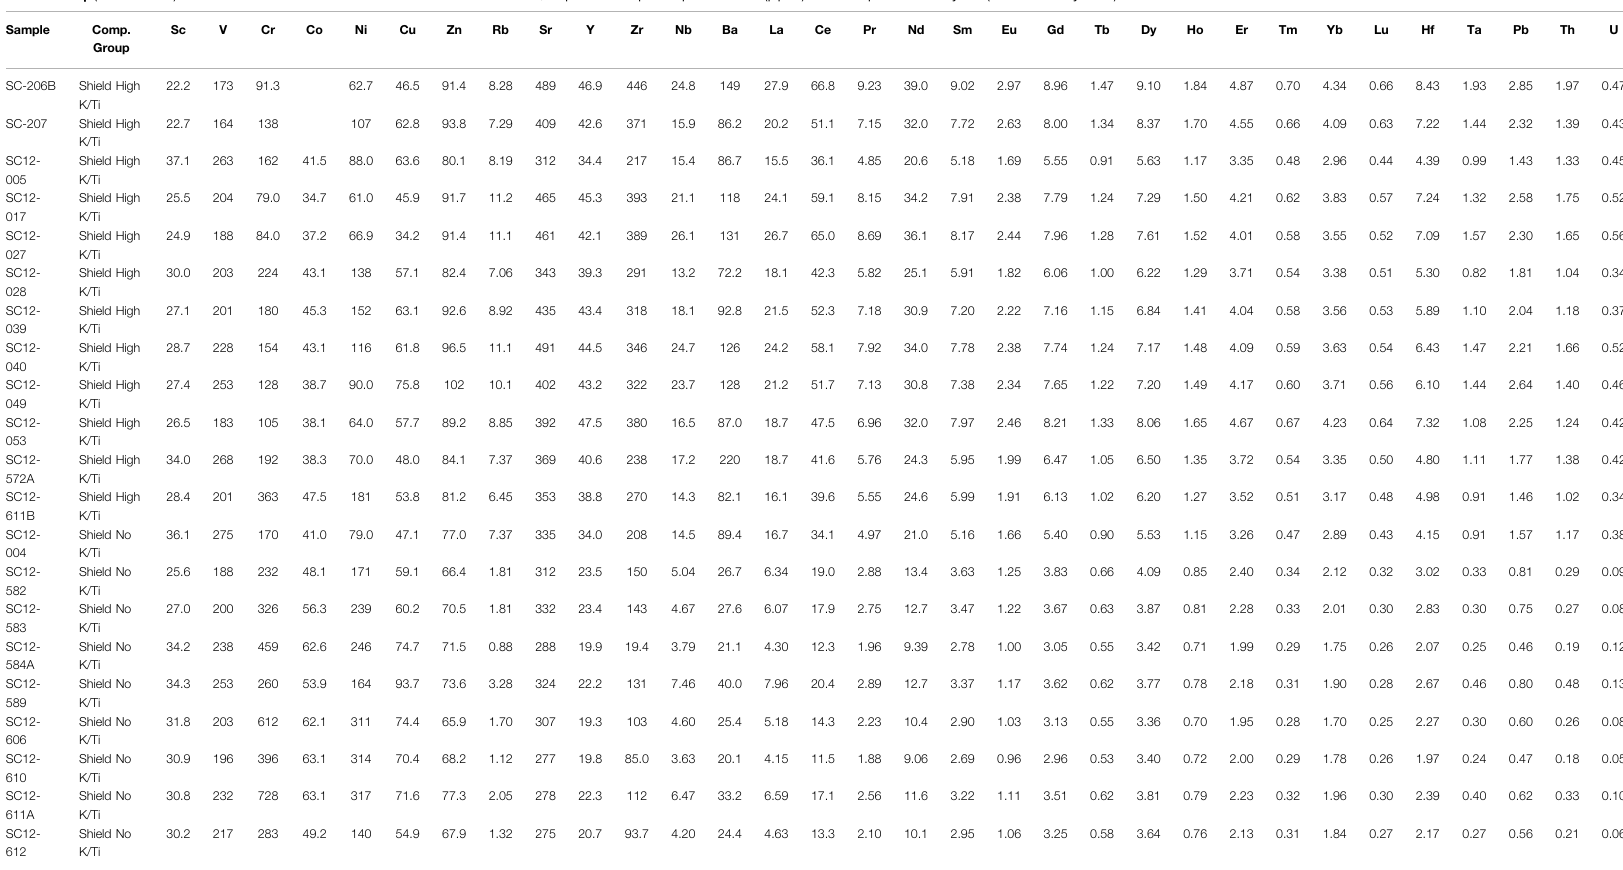
TABLE 2 | ( Continued ) Trace element abundances of Santa Cruz lavas, reported in parts per million (ppm). One replicate analysis (indicated by “ re ” ) is included. Sample Comp.